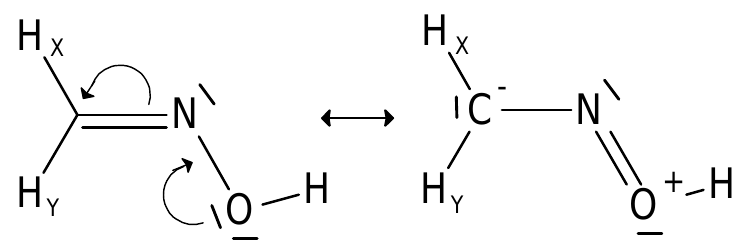
Figure 4. Resonance structures of methanaloxime 2